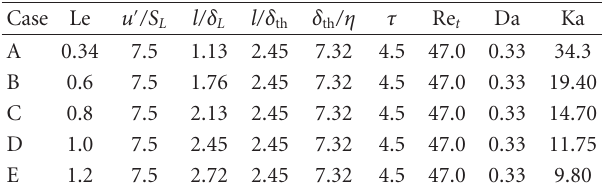
Table 1: Initial values of the simulation parameters and non- dimensional numbers relevant to the DNS